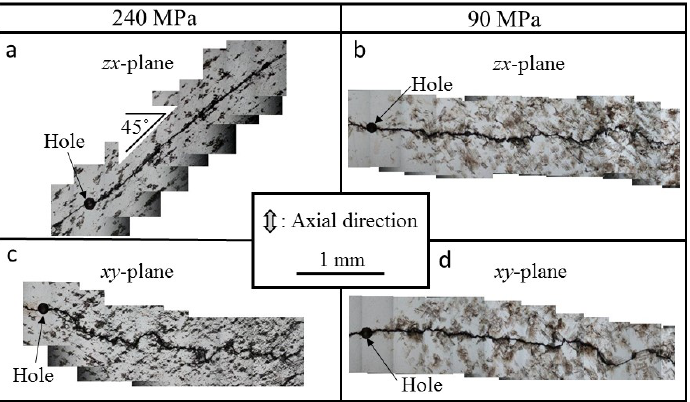
Figure 2: Effect of stress amplitudes on crack growth paths in the zx - and xy planes: (a, and b) the zx -plane crack at  a = 240 and 90 MPa; (c and d) the xy -plane crack at  a = 240 and 90